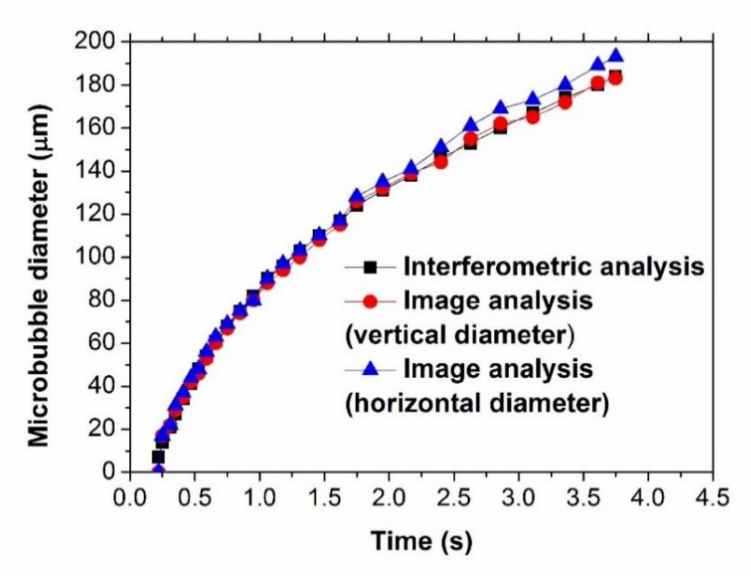
Figure 5. Temporal evolution of the microbubble